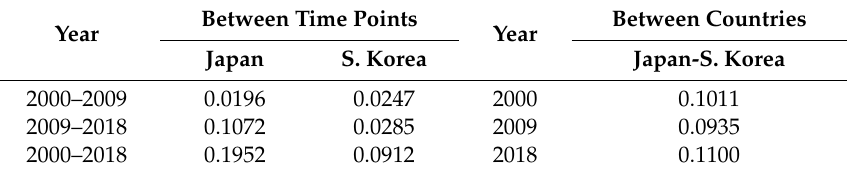
Table A1. Fuel Distance between Japan and Korea over Time.